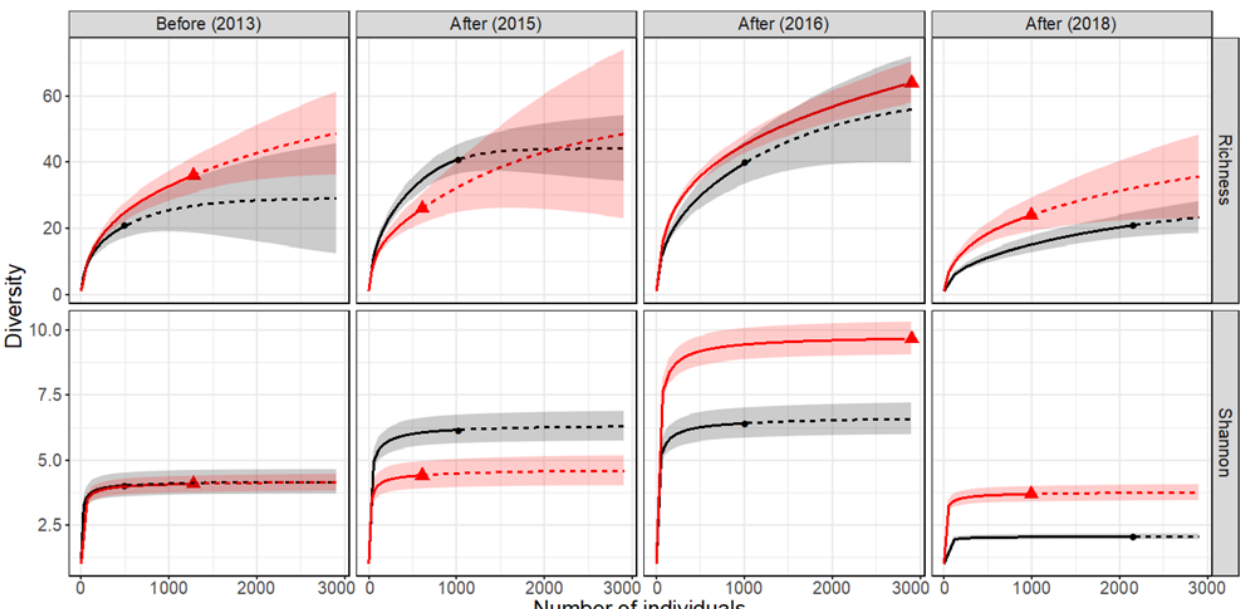
Figure 4. Sample-size based rarefaction (solid line segment) and extrapolation (dotted line segments) diversity curves for hyporheic assemblages in control (black) and impact (red) reaches of the River Lambourn pre and post restoration. The shaded areas represent 95% confidence intervals. 1.